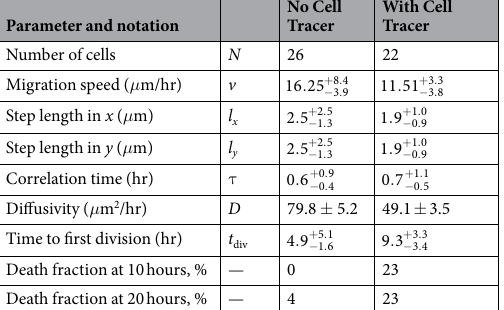
Table 1. Summary of parameters acquired for single cells cultured in the absence and presence of Cell Tracer. The entries are representative median values, with errors given by the lower and upper quartiles. The exception is the diffusivity, which is presented as a mean and 95% confidence interval. The step lengths and migration speed were calculated by averaging over all cells at all times (15 min intervals). The diffusivity was obtained using the fits to L 2 shown in Fig. 3 and the correlation time from τ = 2 D / v 2 for instantaneous speeds.